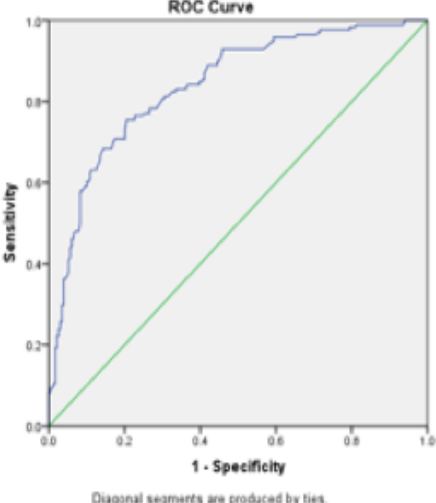
Fig. 5: ROC curve for right hand index of female